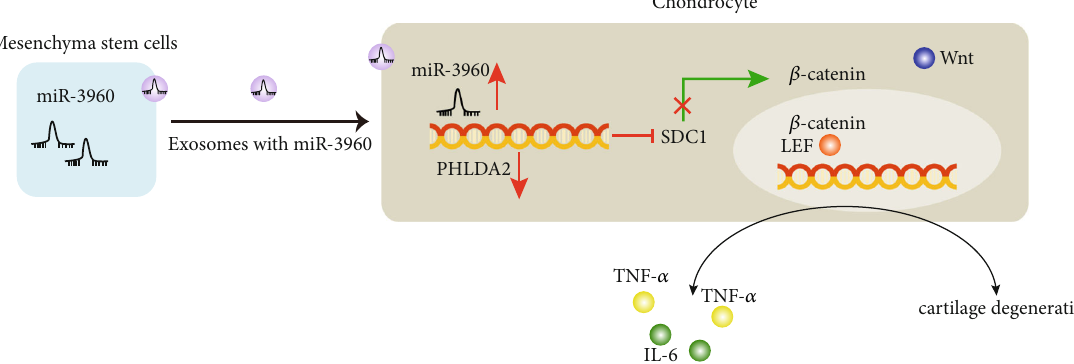
Figure 9: MSCs-EVs carrying miR-3960 inhibits PHLDA2 to suppress SDC1 and the Wnt/ β -catenin pathway activation, thereby repressing the chondrocyte injury in